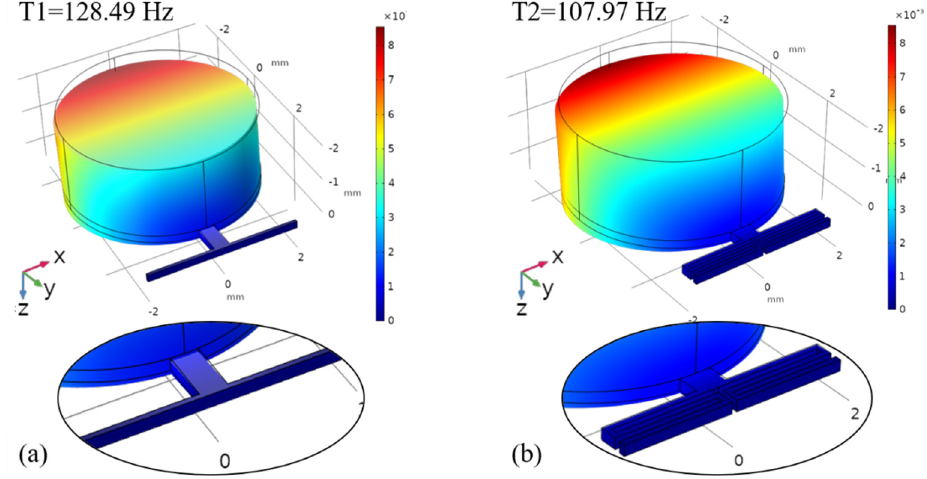
Figure 3. FEM modal analysis of the EVEH: ( a ) T1 device (128.49 Hz); ( b ) T2 device (107.97 Hz).